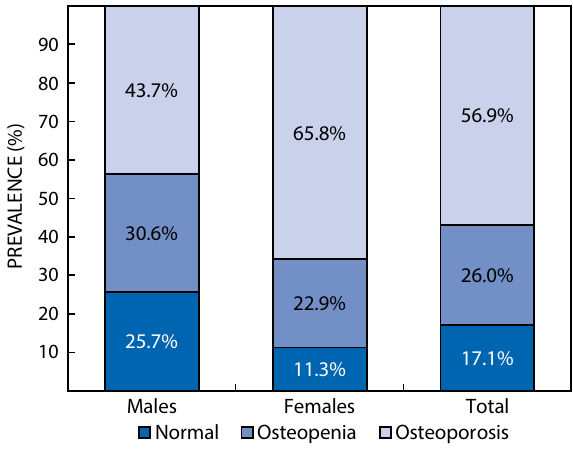
Figure 1: Point prevalence of osteopenia and osteoporosis using Dual Energy X-ray Absorptiometry (DXA).